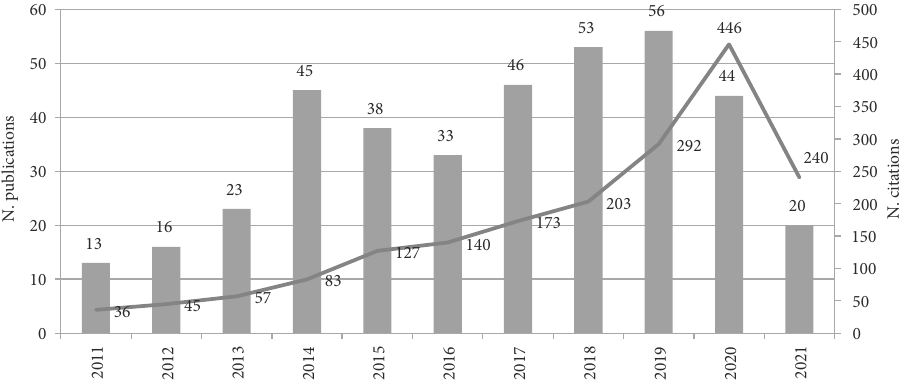
Figure 3. Total publications and citations by year – final database from 2011 to